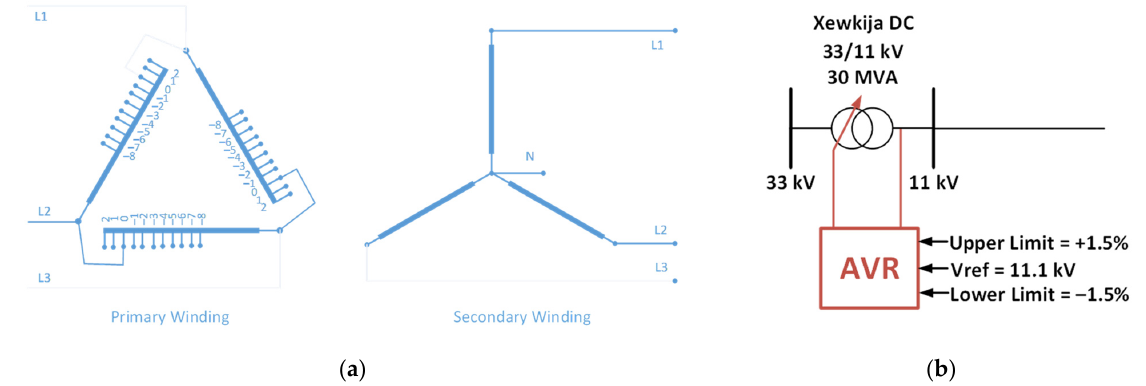
Figure 4. ( a ) Xewkija DC 33/11 kV Delta/Star Transformer with taps on the primary winding; ( b ) voltage regulation by the OLTC at Xewkija DC with an AVR. ( b ) voltage regulation by the OLTC at Xewkija DC with an